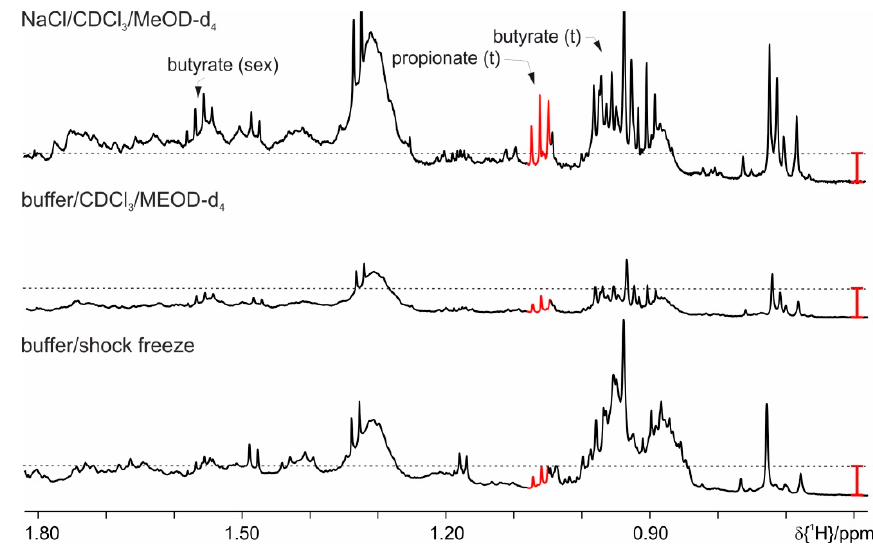
Figure 6. Proton spectra for the two phase protocols, on feces from mice on HFD, where basic protocol with shock freeze (buffer/shock freeze) is compared with a lipid extraction performed with buffer and organic phase or with the use of sodium chloride. The red bar indicates the increased signal intensities.